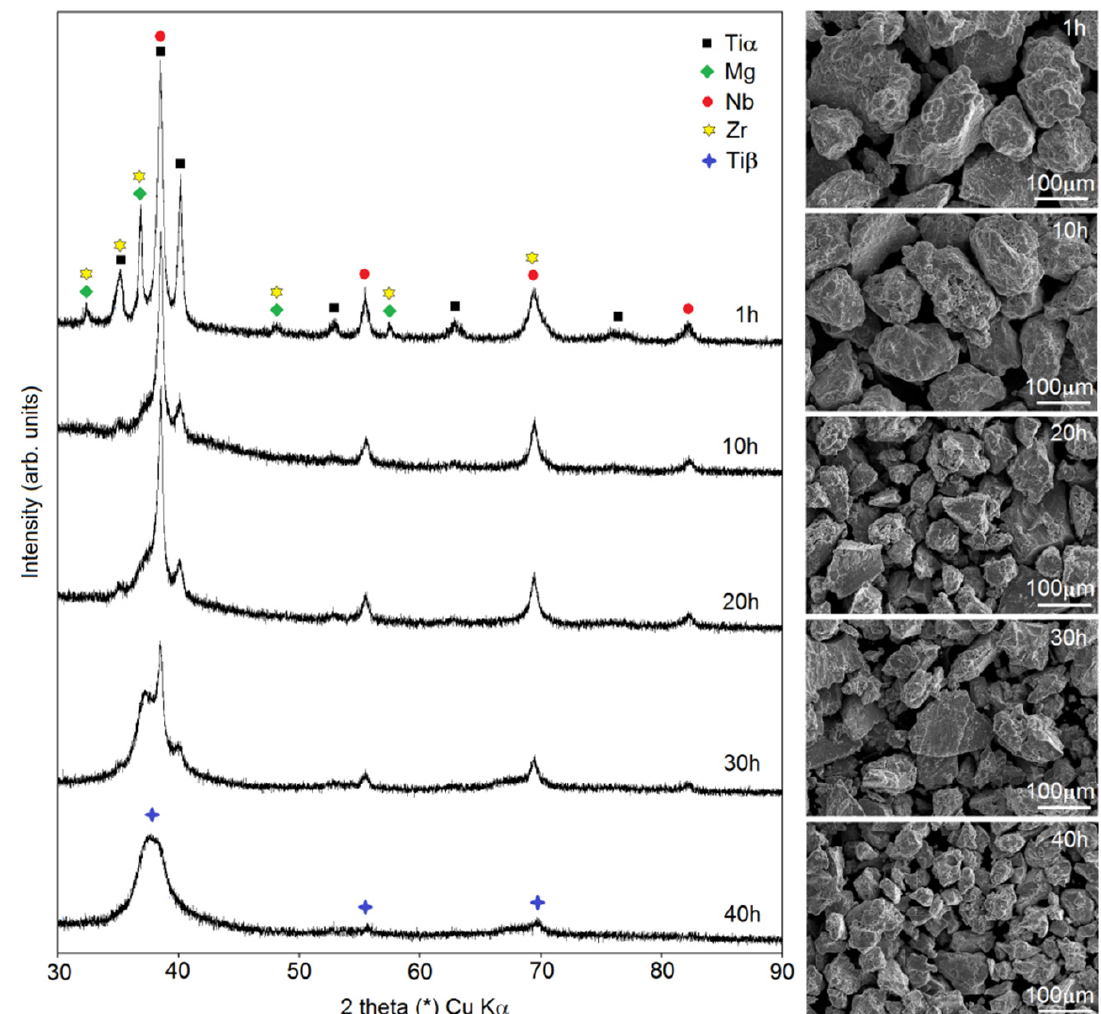
Figure 1. XRD spectra of the Ti20Nb5Zr30Mg and SEM micrographs of the powders at various milling times.